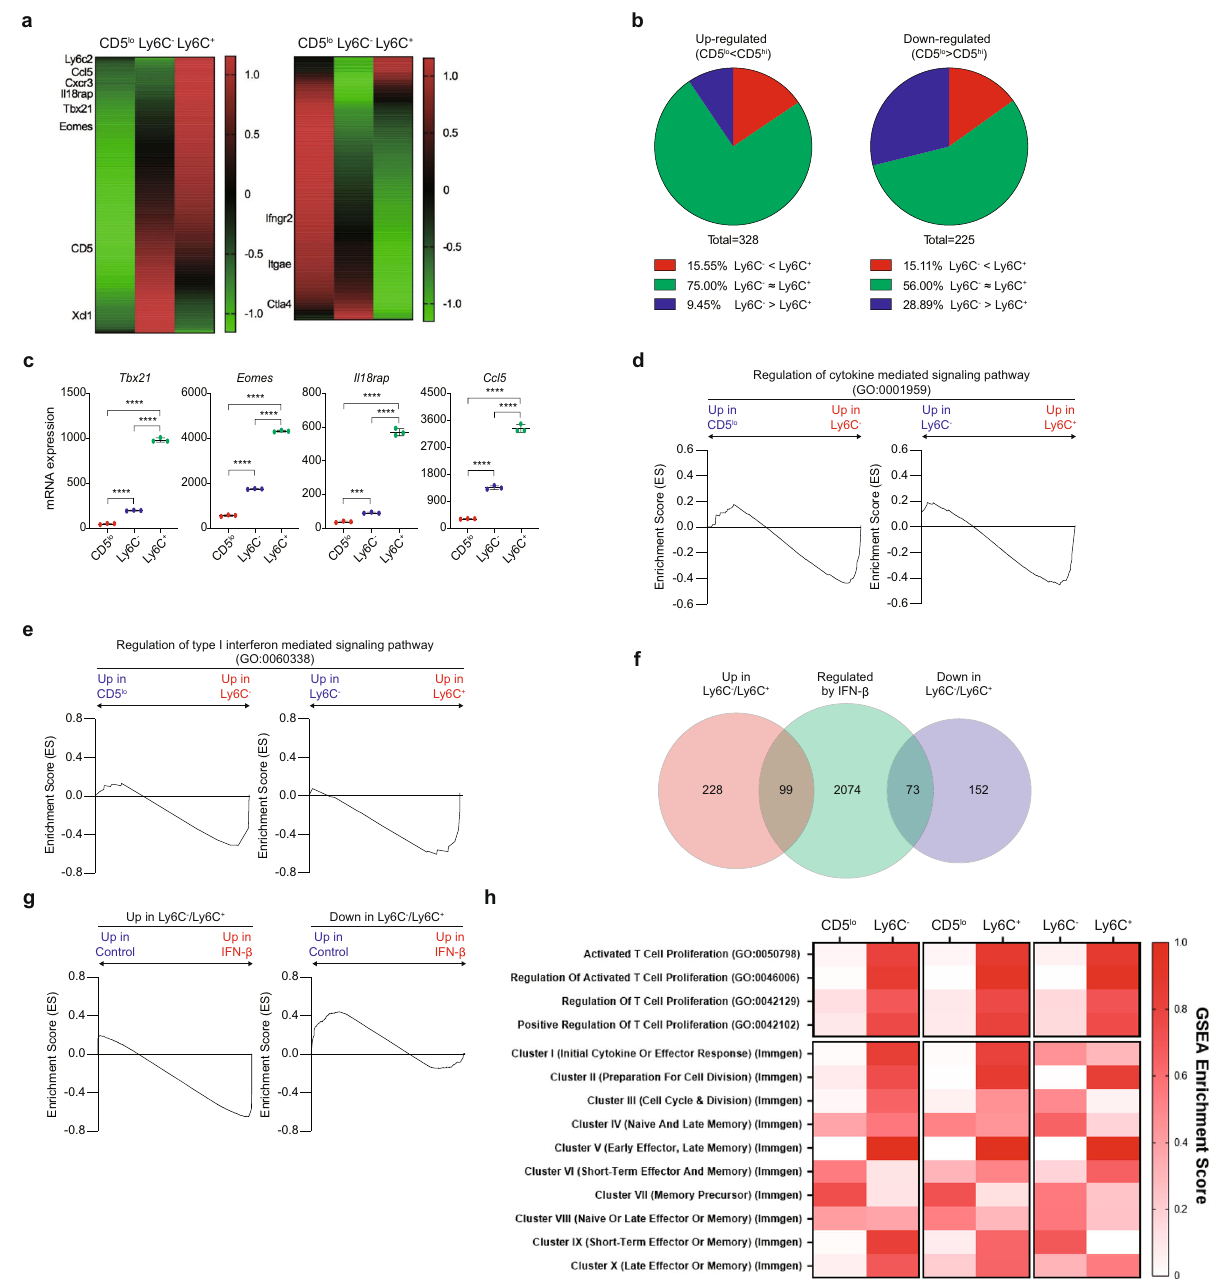
Fig. 3 Type I IFN affects transcriptomes of naive CD8 + T cells in a steady-state. a Heat map of genes that are either up-regulated ( n = 328 genes) (left panel) or downregulated ( n = 225 genes) (right panel) in FACS-puri fi ed B6 naive CD5 hi (Ly6C − and Ly6C + ) CD8 + T cells compared to CD5 lo cells. The color scale is based on Z -score scaling from -1.2 (Green) to 1.2 (Red). b Pie charts illustrating genes that are regulated similarly or differently in Ly6C − and Ly6C + cells in up- (left panel) or downregulated (right panel) genes. c RT-PCR results of Tbx21, Eomes, Il18rap, and Ccl5 genes in CD5 lo , Ly6C − and Ly6C + cells. Y -axis represent relative mRNA expression ( n = 3 mice for each group). Statistical signi fi cance was con fi rmed by two-tailed unpaired Student ’ s t -test. Results are shown as mean ± SD. Data representative of two independent experiments. d , e GSEA results between CD5 lo and Ly6C − , or Ly6C − and Ly6C + cells for pathway: Regulation of cytokine mediated signaling pathway (GO:0001959) ( d ) and Regulation of type I interferon mediated signaling pathway (GO:0060338) ( e ). f Venn diagram between up- or downregulated genes in CD5 hi cells and IFN- β regulated genes. g GSEA results between cells cultured with or without IFN- β for up- (right panel) or downregulated (left panel) genes. h GSEA were performed between CD5 lo and Ly6C − , CD5 lo , and Ly6C + , or Ly6C − and Ly6C + for indicated pathways. GSEA Enrichment Score (ES) represent absolute value of either minimum or maximum running enrichment score. The color scale is based on ES, scaling from 0 (White) to 1.0 (Red). Source data are provided as a Source data fi